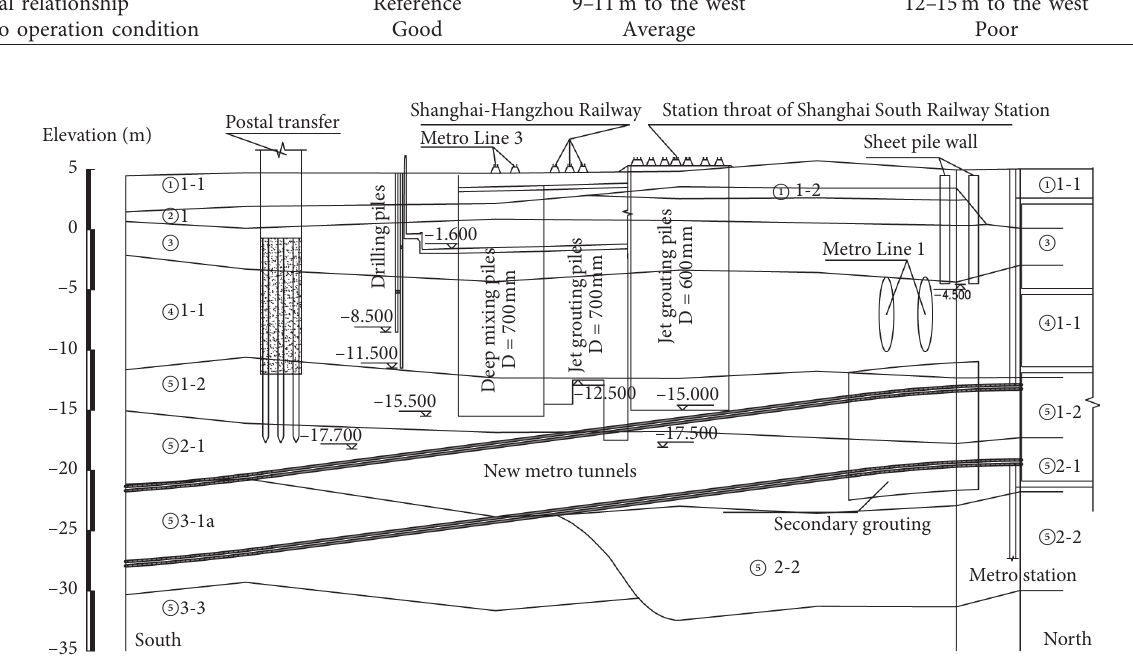
Figure 4: Profile of the selected line alignment scheme (scheme 2).